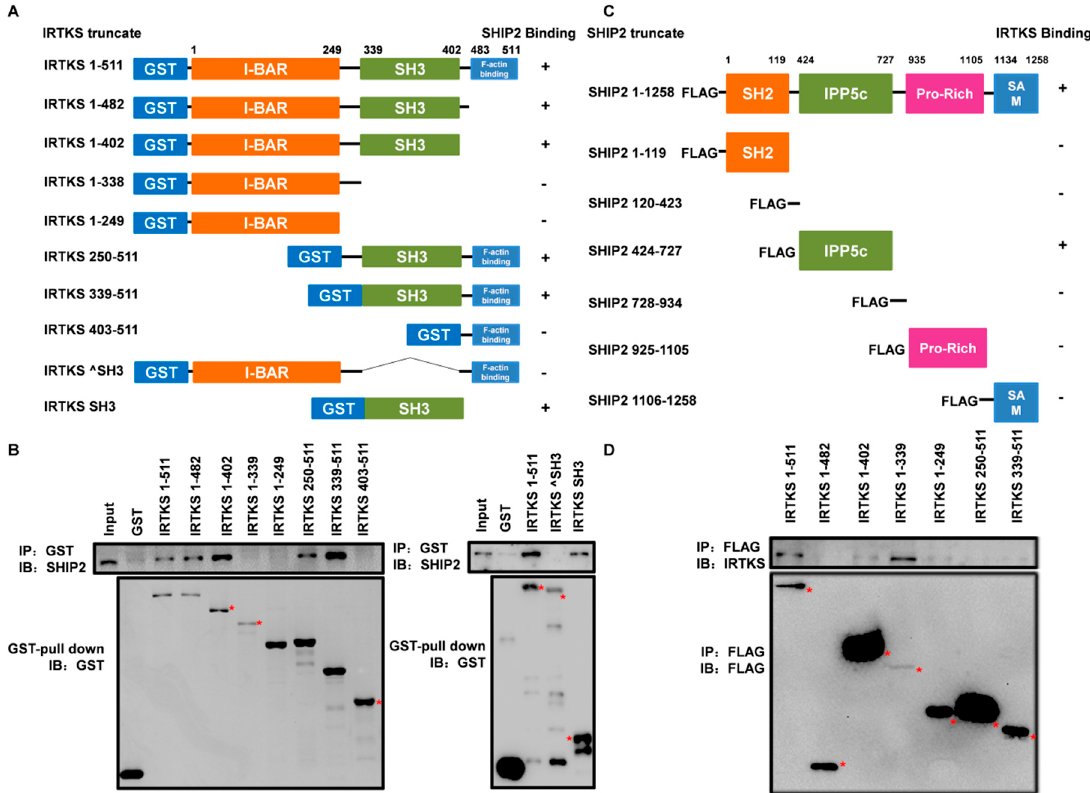
Figure 2. The SH3 domain of IRTKS binds to the inositol polyphosphate-5-phosphatase domain (IPP5c) of SHIP2. ( A ) A schematic diagram of glutathione S-transferase (GST)-tagged IRTKS constructs encoding its full length and truncated proteins. ( B ) GST-tagged IRTKS fusion proteins purified from Escherichia coli ( E. coli ) (BL 21) were added to the HEK293T cell lysates to pull down SHIP2. ( C ) A schematic diagram of Flag-tagged SHIP2 constructs encoding its full length and truncated proteins. ( D ) The Flag-tagged SHIP2 fusion proteins overexpressed in HEK293T were pulled down by endogenous IRTKS. Red asterisks indicate the fusion proteins with correct molecular weight.